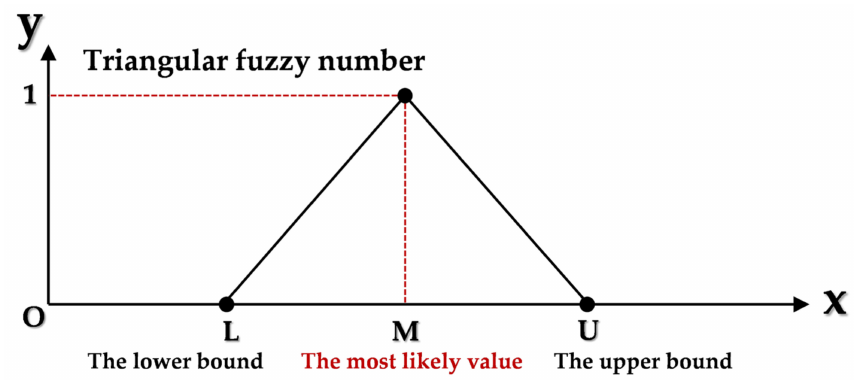
Figure 10. Schematic diagram of each parameter in TFNs.